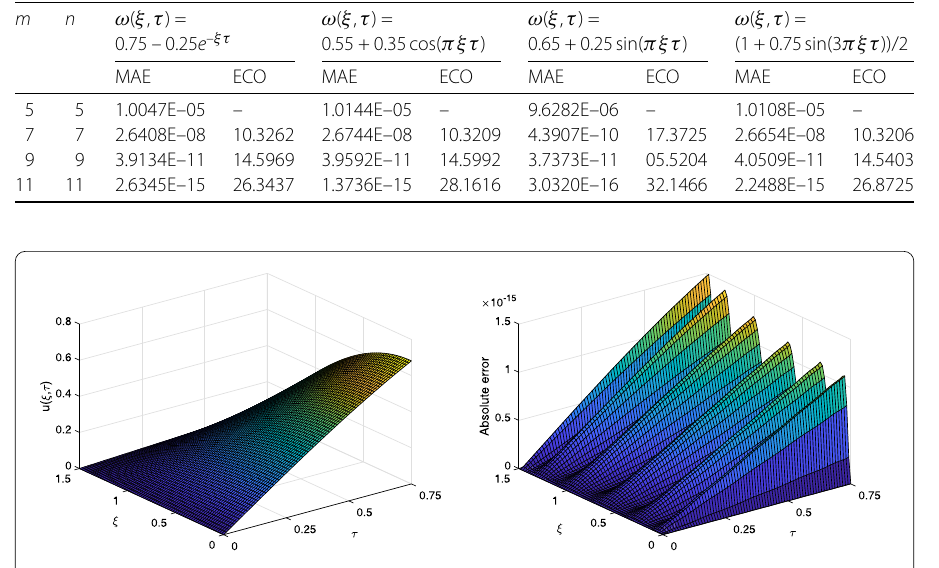
Table 2 Numerical results obtained for Example 4 with some selections ω ( ξ , τ )